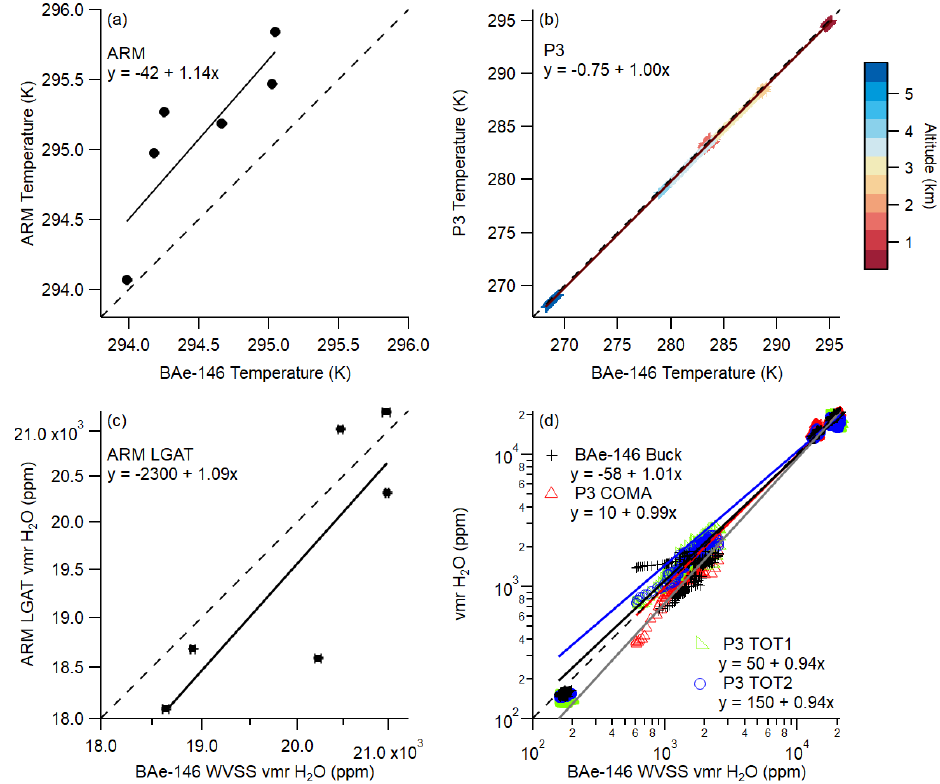
Figure 5. Correlations from various flight segments (Table 2) between temperatures for (a) FAAM BAe-146 and LASIC ARM site and (b) FAAM BAe-146 and NASA P3 and for humidity vmr for (c) FAAM BAe-146 and LASIC ARM site and (d) FAAM BAe-146 and NASA P3. In panel (b) the data points are coloured by altitude. In panel (d) the instruments are given a different colour for